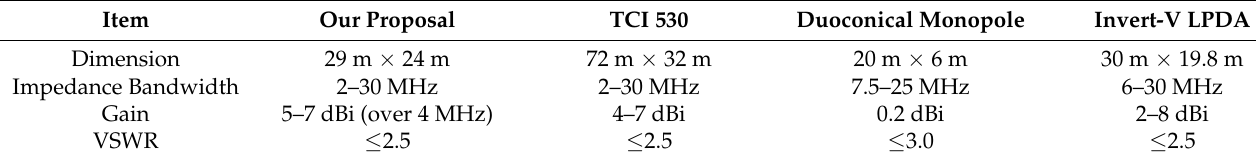
Table 1. Comparison of our proposal and the other antennas.